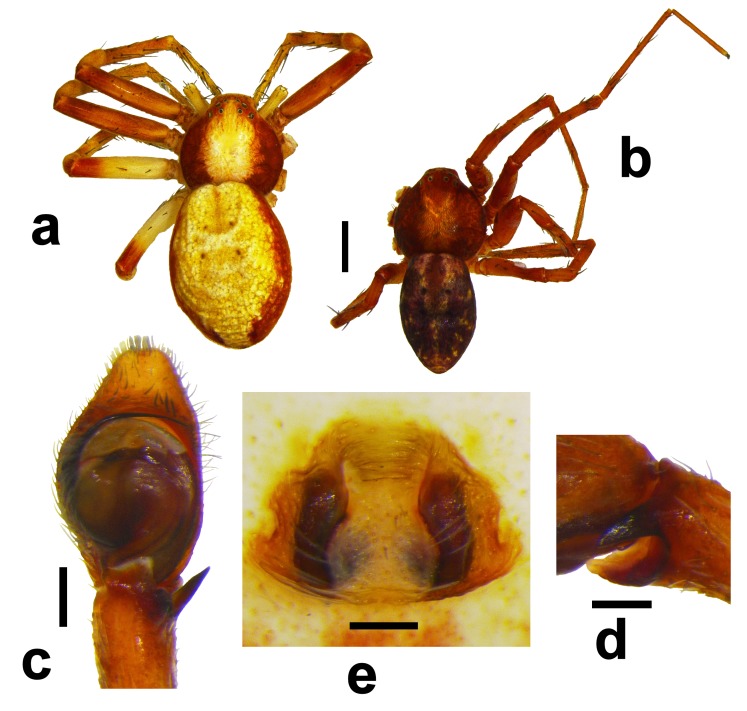
Philodromus
buchari Kubcová, 2004. a: female, dorsal habitus, scale = 1 mm; b: male, dorsal habitus, scale = 1 mm; c: left male palp, ventral, scale = 0.2 mm; d: left male tibial apophysis, retrolateral, scale = 0.2 mm; e: female epigynum, ventral, scale = 0.2 mm.